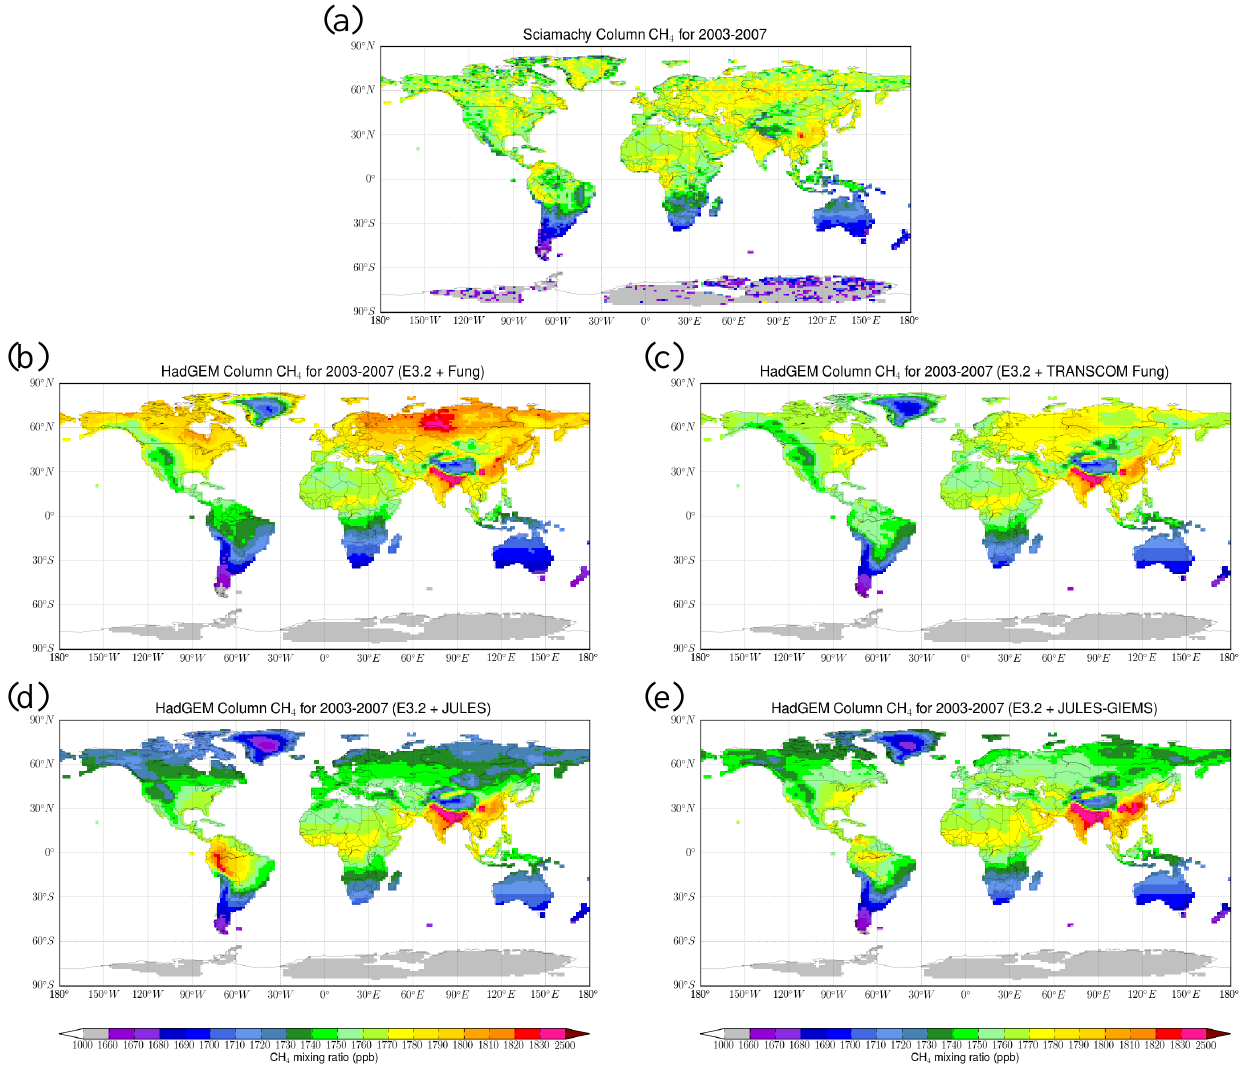
Figure 8. Contour maps of the average atmospheric column methane mixing ratio between the years 2003 and 2007, as derived from monthly regridded SCIAMACHY data (a) and from the HadGEM2 runs using the FUNG (b) , TRANSCOM-FUNG (c) , JULES (d) and JULES-GIEMS (e) wetland emission inventories and the EDGAR v3.2 (E3.2) anthropogenic methane emission time series, sampled at co-located space and time